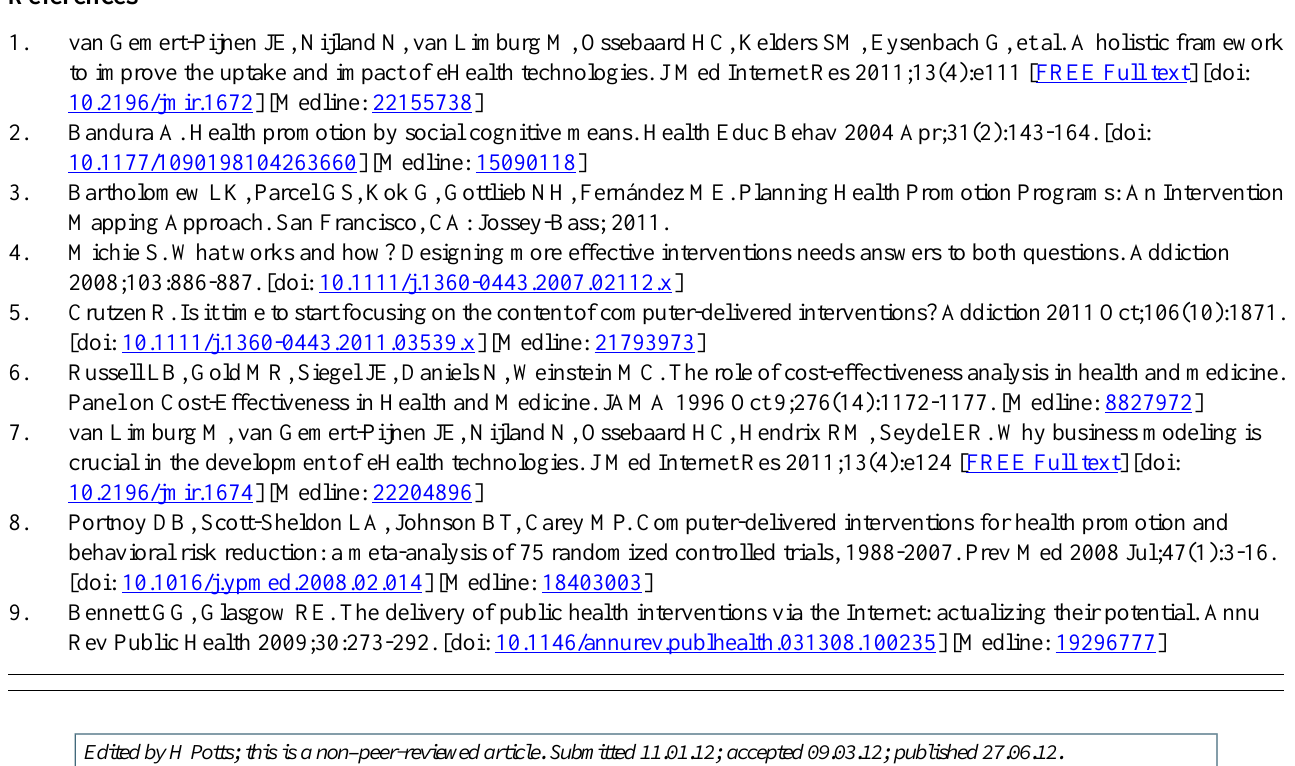
Intervention MappingHolistic